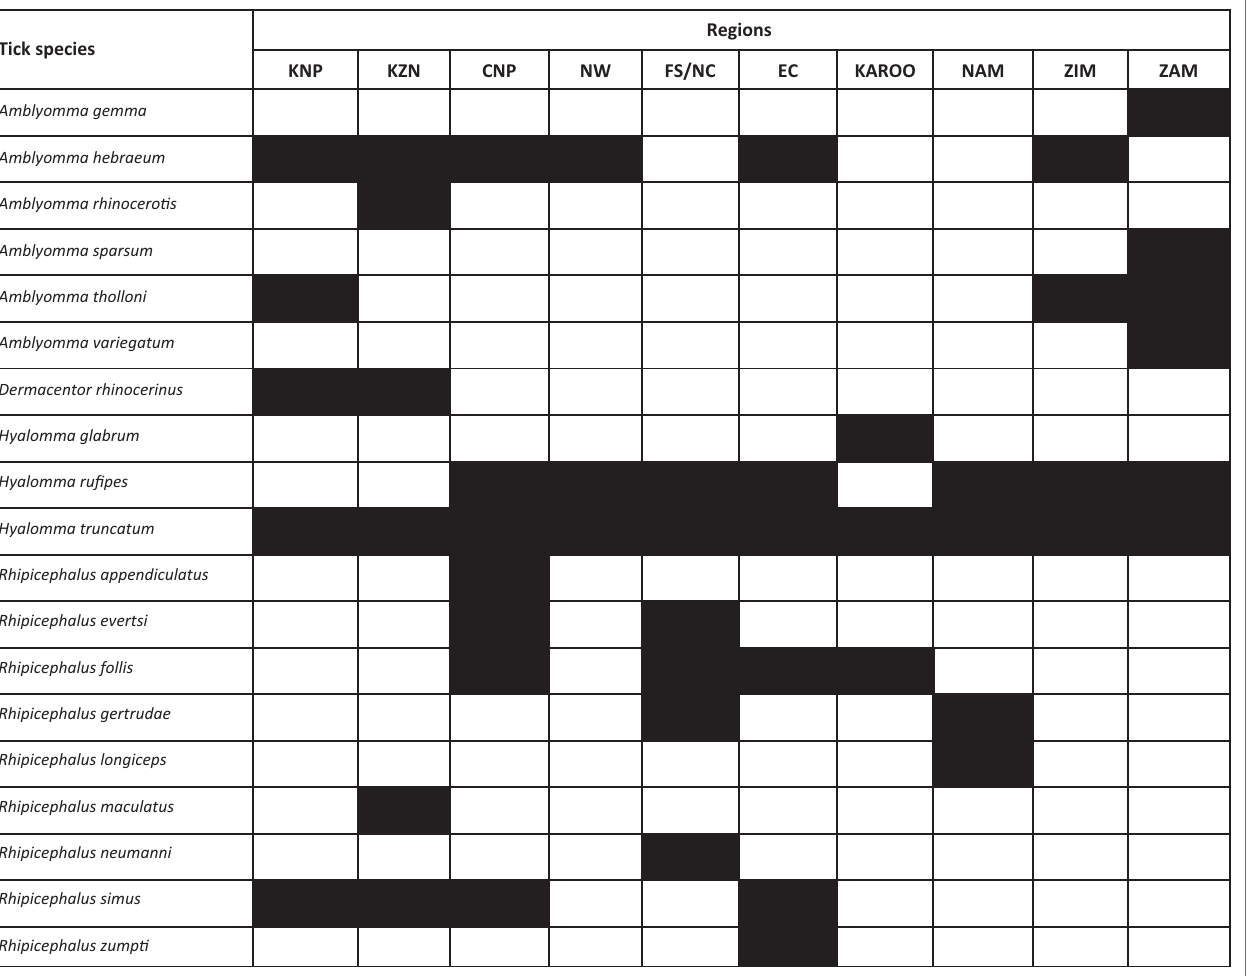
FIGURE 1: The regional distribution of ticks that infest rhinoceroses in southern